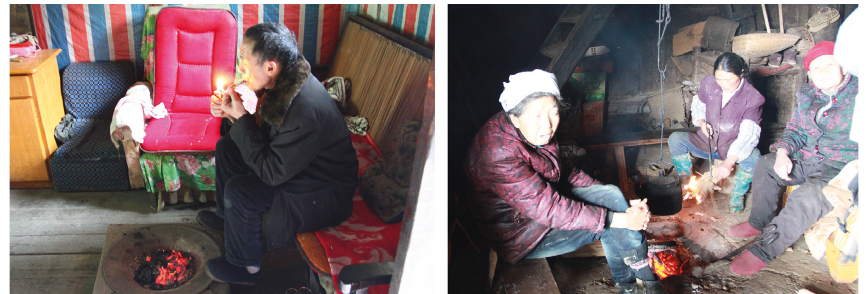
Figure 2: Traditional heating and cooking methods commonly used in central and southern China.